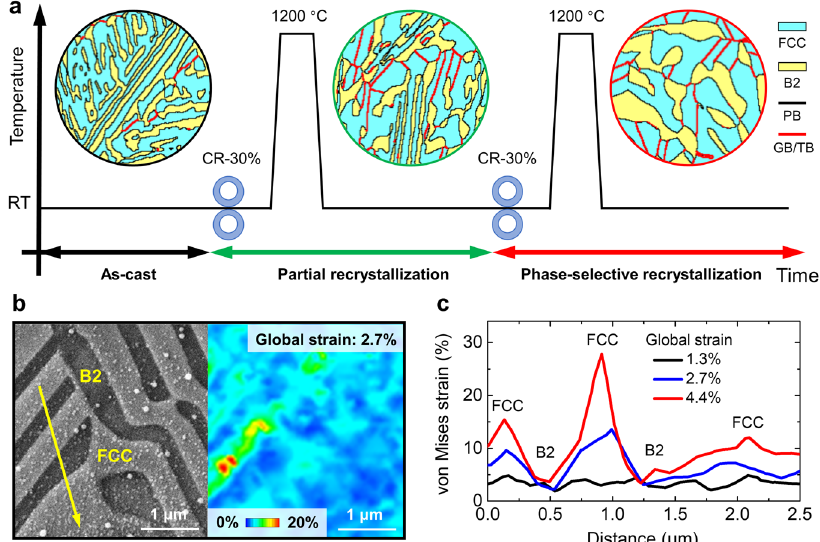
Fig. 4 | Processing routes and formation mechanisms of the PSR. a Schematic illustration of the processing routes and corresponding microstructure evolution. For PSR, the AC EHEA was cold-rolled (CR) 30% and annealed at 1200°C for two cycles. The FCC phase, B2 phase, PB, and GB/TB are marked in cyan, yellow, black,